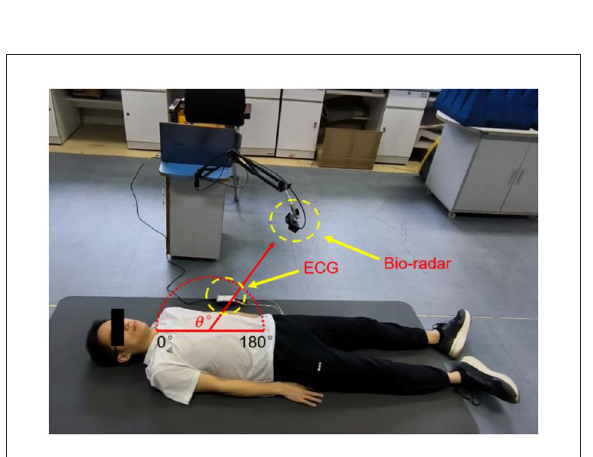
FIGURE14 Synchronous acquisition experiment of RCG and